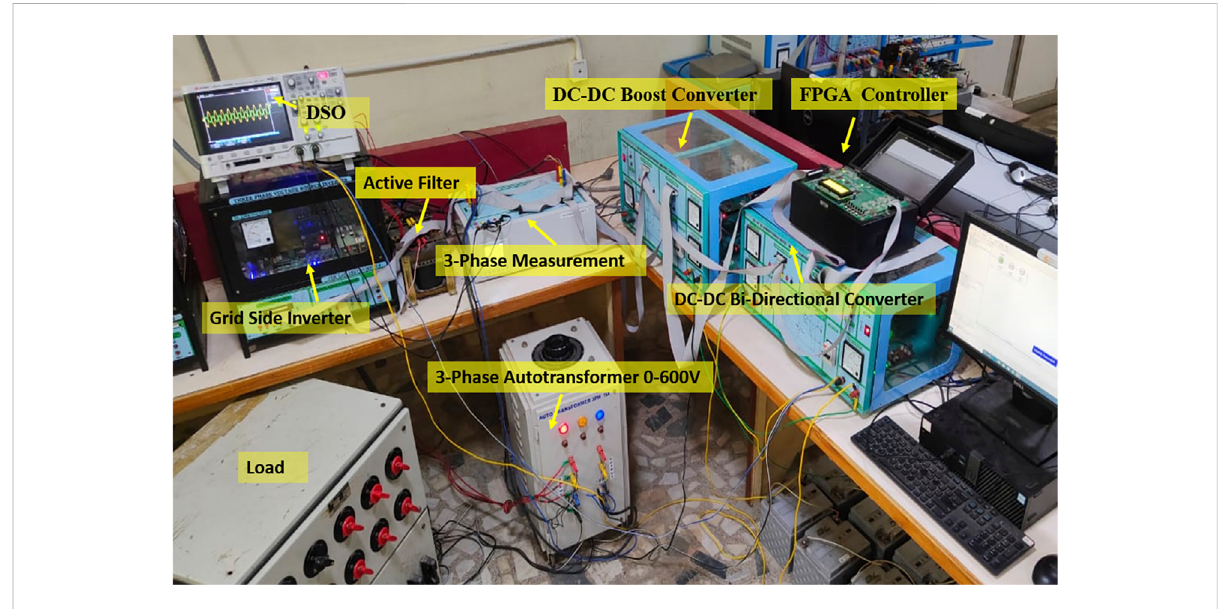
FIGURE 2 Experimental setup of 5 kVA grid-integrated solar